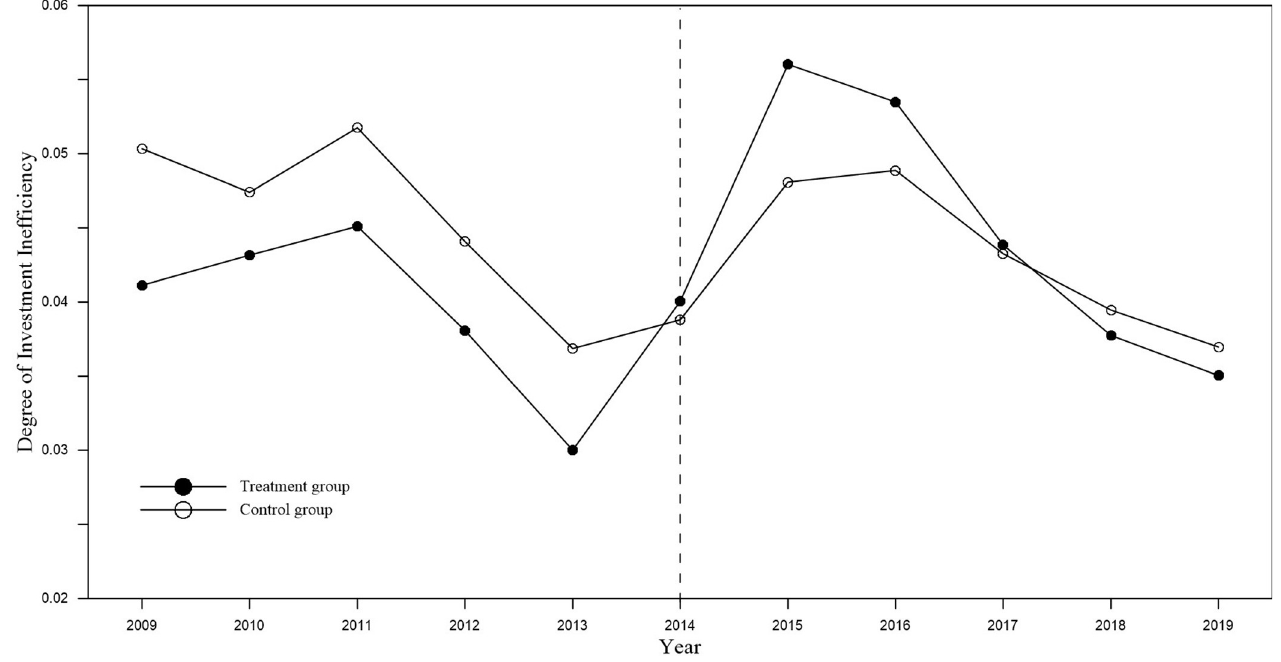
Fig 4. The change trend of investment inefficiency of experimental and control group.